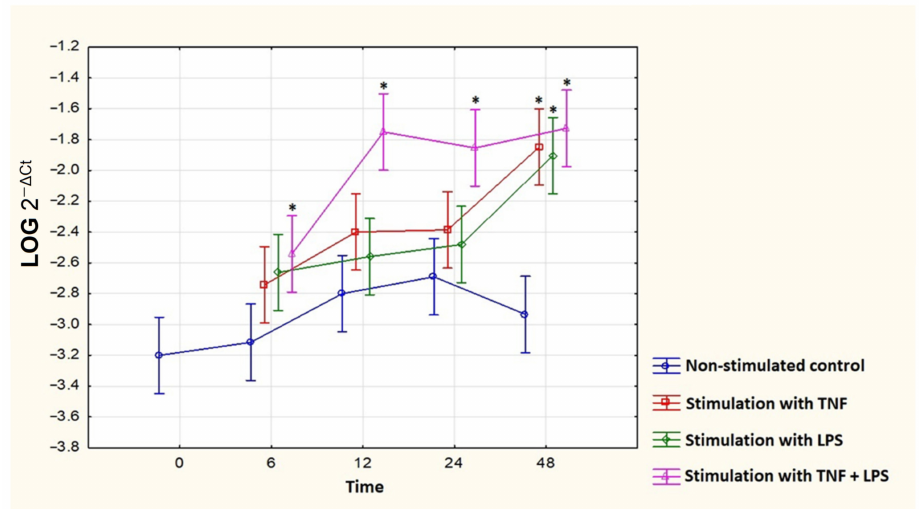
Figure 6. Effect of stimulation of human fibroblast-like synoviocytes (HFLSs) with LPS, TNF- α , and LPS + TNF- α on adiponectin mRNA expression. Means from 3 experiments ± 95% confidence intervals are presented. * p < 0.05 (Tukey post hoc test in comparison to non-stimulated control). TNF: Tumor necrosis factor. LPS: Lipopolysaccharide.